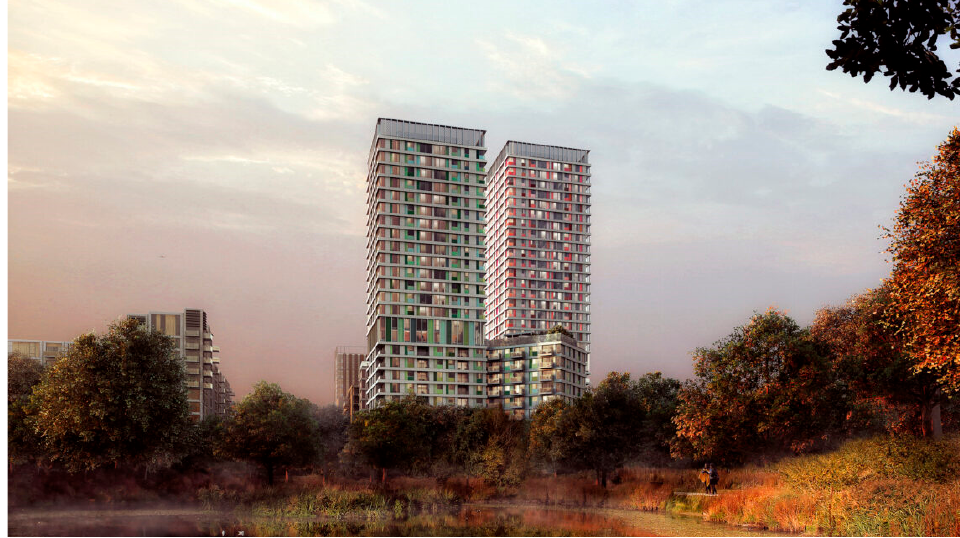
Figure 6. East Village Plot No:6 (credit: Hawkins\Brown, 2020).